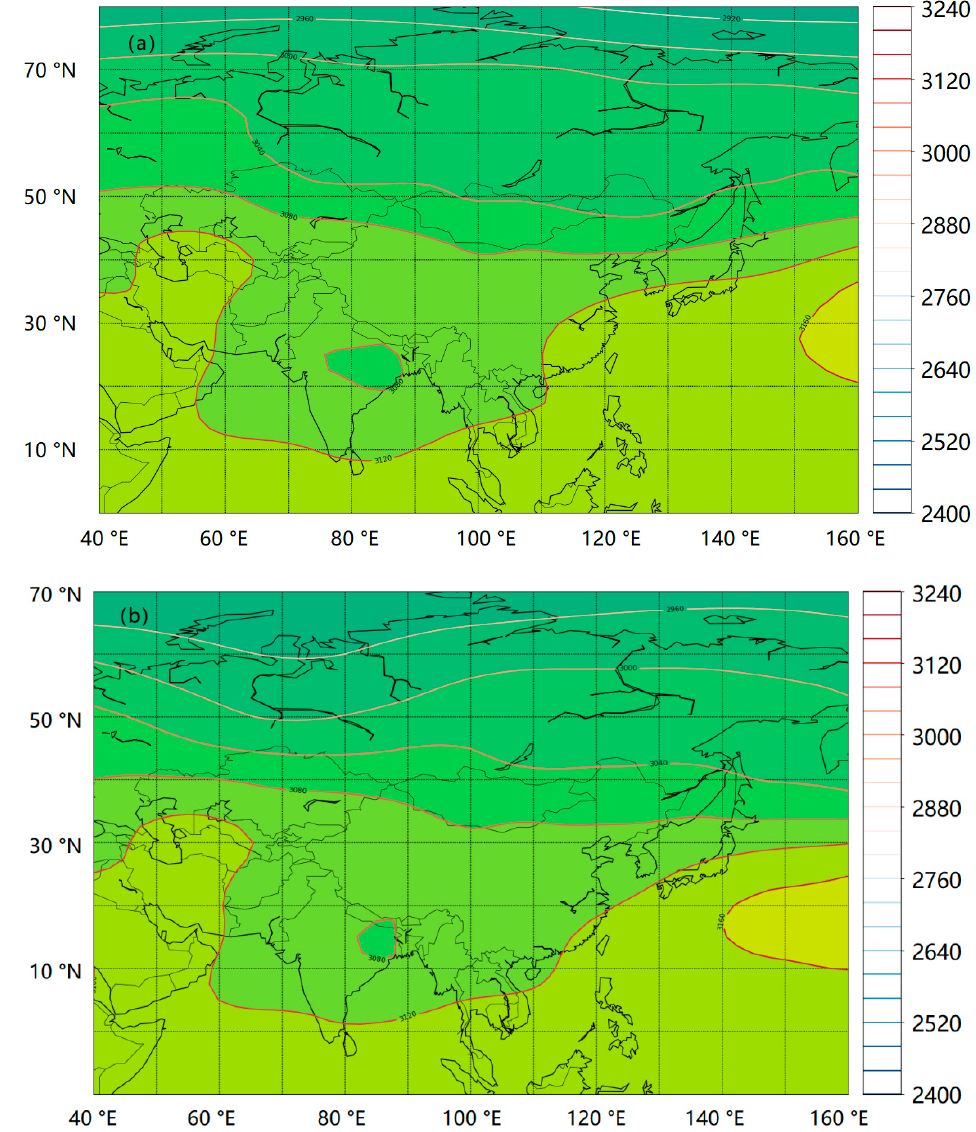
Figure 12. Average 700 hpa height field in a typical high-temperature year in July in East China with ( a ) more and ( b ) fewer EMTEs in East China.